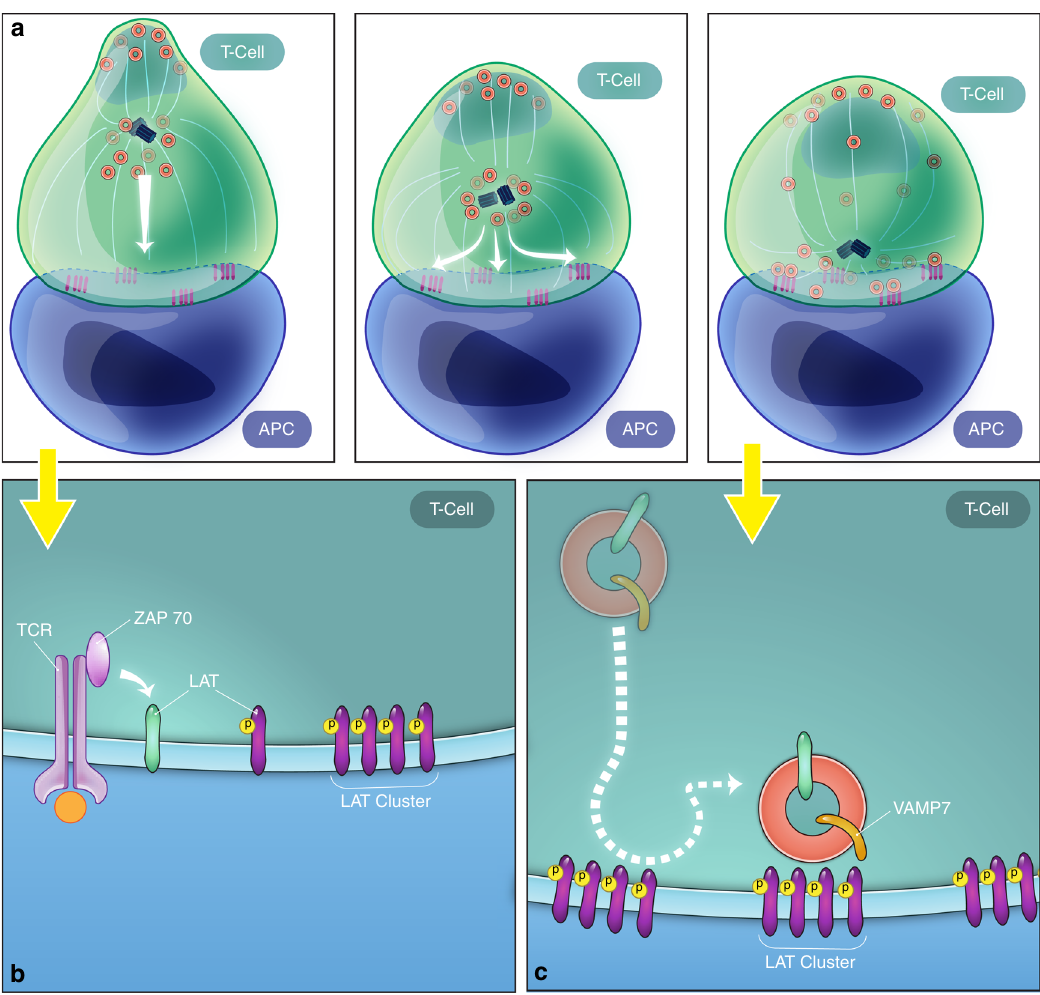
Fig. 8 Two-phase model for LAT activation. A model for LAT microcluster formation and maintenance using the two cellular pools of LAT is shown. a The left panel shows that at early time points, LAT vesicles decorated with VAMP7 are several microns away from the immune synapse, while plasma membrane-resident LAT can move laterally to be recruited to microclusters. The middle and right panels show that microtubule polarization toward the immunological synapse causes the reorientation of various vesicular compartments to the subsynaptic zone. b , c Zoomed-in regions of early and late stages of activation, respectively. b At early time points, plasma membrane LAT is recruited to microclusters and activated ZAP-70 phosphorylates LAT at the PM. c At later time points, LAT/VAMP7 vesicles are recruited to the immune synapse, move in a directed manner between microclusters, and interact dynamically with